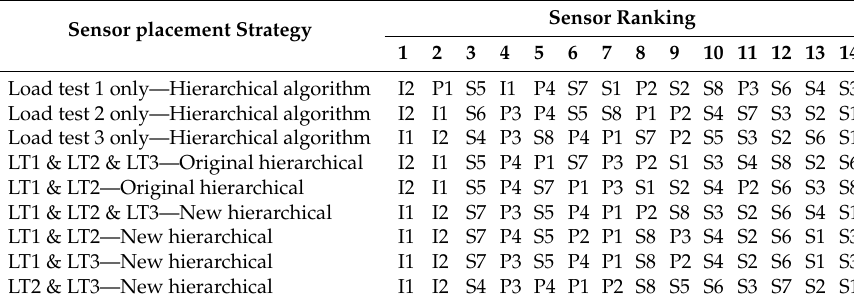
Table 3. Summary of sensor ranking from the various sensor placement